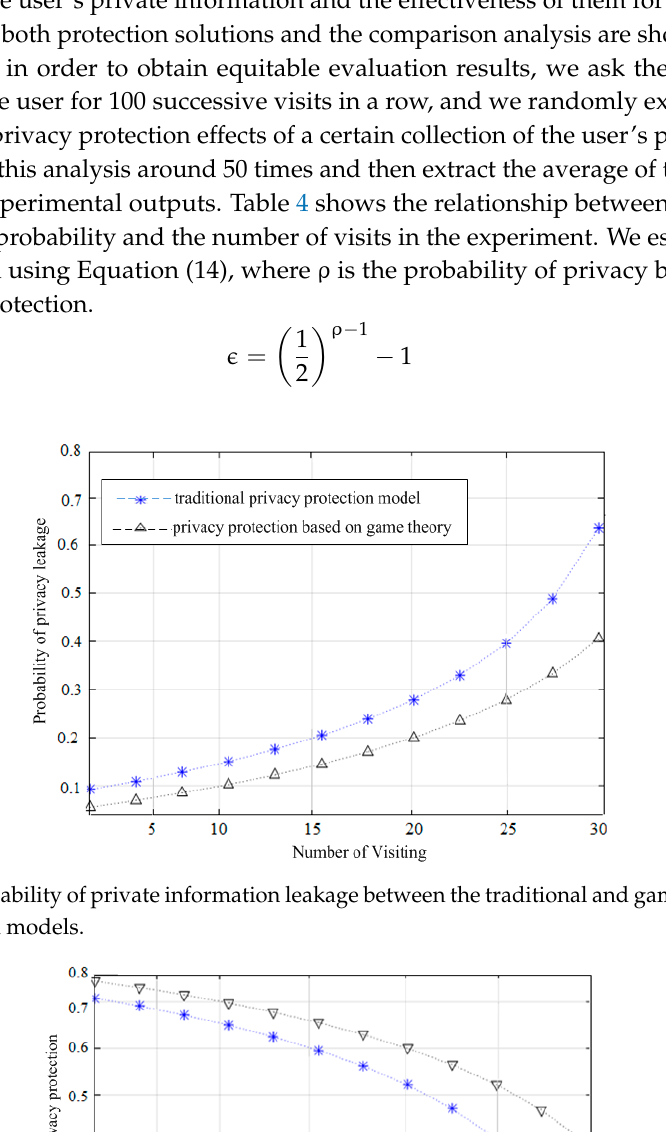
Table 5. The relationship between the threshold imposed by the user and the number of access results. Threshold Figure 6. Relationship between the threshold values and tolerance of game theory-based privacy protection model. Furthermore, another feature of the game theory-based protection model is the flexible setting of the privacy threshold imposed by the user. The user sets the sensitivity or the privacy information protection requirement to decide whether to allow or deny the visitor to access his/her information. This privacy threshold value is used to compare with the visitor’s probability to adopt the ‘‘good-faith access to the user’s private information” strategy. The “allow access to the user’s trajectory” strategy is adopted only when the probability of the visitor’s good-faith access is not less than the access threshold imposed by the user, otherwise, the “refuse access” strategy is adopted. Figure 6 shows that in the game-based privacy protection model, as the threshold increases, the number of visits to the user’s tolerance of private information leakage is reduced, i.e., the audience is less tolerant of private information leakage. Conversely, the lower the threshold, the more visitors’ good-faith access will not exceed the number of visits to protect the user’s privacy, i.e., the user’s tolerance of private information leakage is higher. 5. Related Works